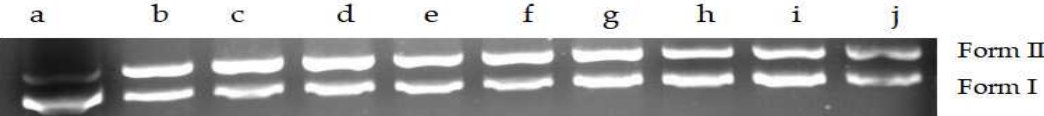
Figure 13. Effect of MA on topoisomerase I of S. aureus. Note: Form II (open circular DNA and linear); Form I (supercoiled DNA); a: pET-28a; b: topoisomerase; c: DMSO; d–j: 0.156 mg/mL; 0.3125 mg/mL; 0.625 mg/mL; 1.25 mg/mL; 2.5 mg/mL; 5 mg/mL; 10 mg/mL.